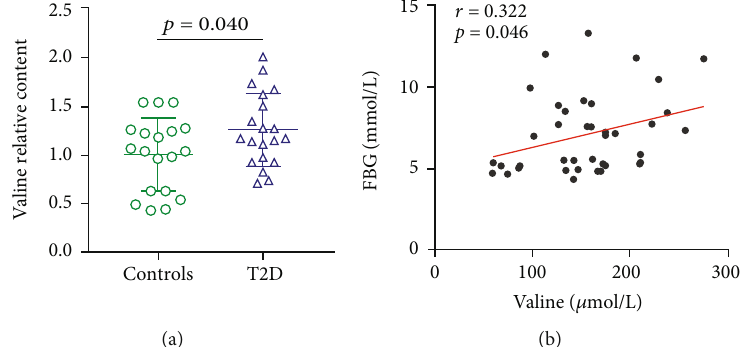
Figure 2: The plasma valine level was higher in T2D patients. (a) The plasma level of valine in healthy controls ( n = 19 ) and T2D patients ( n = 20 ). (b) The correlation between plasma valine level and fasting plasma glucose concentration ( n = 39 ). The data in (a) are presented as the means ± SD , t